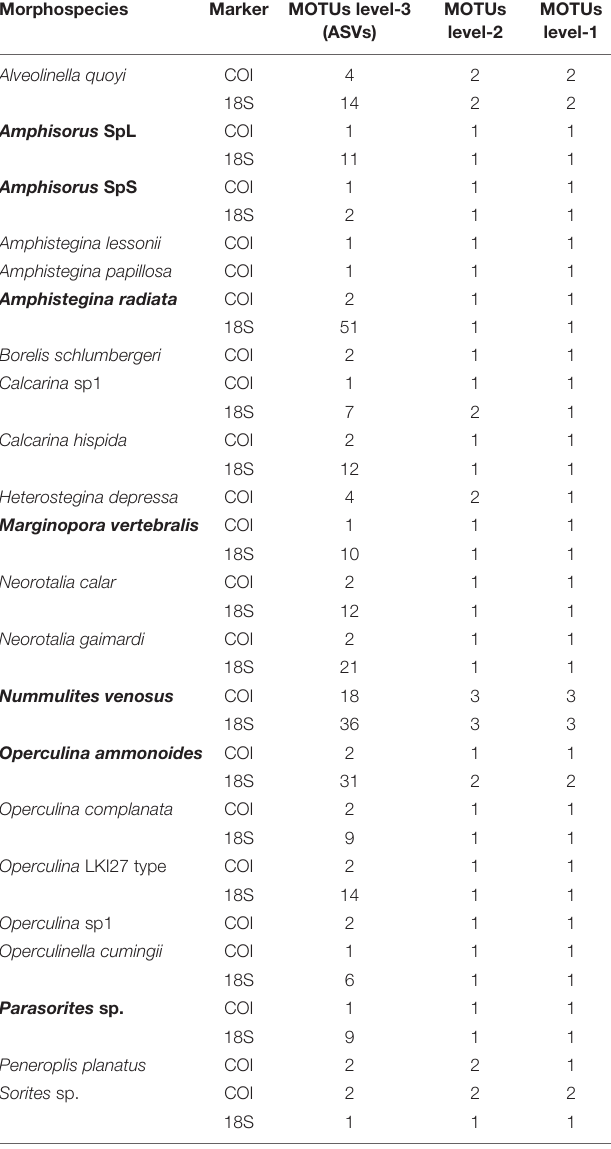
Specimens with five or more specimens for both markers (marked in bold) were further analyzed for comparison between